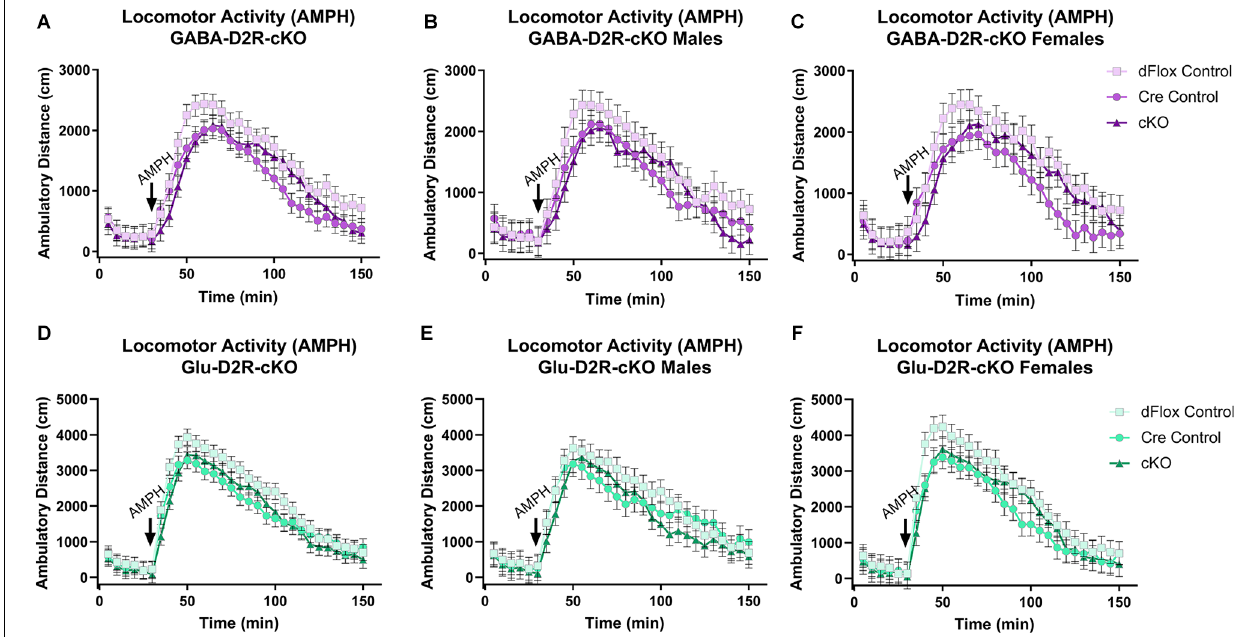
FIGURE 6 | No changes in amphetamine-induced locomotor activity in GABA-D2R-cKO and Glu-D2R-cKO mice. Amphetamine (AMPH) administration induced hyperactivity in all mice, but there were no differences between groups when D2Rs were knocked down in cortical GABAergic interneurons (A–C) or glutamatergic neurons (D–F) . Data are depicted as collapsed across sex (A,D) as well as for males (B,E) and females (C,F) separately. N = 6–7/genotype × sex group.